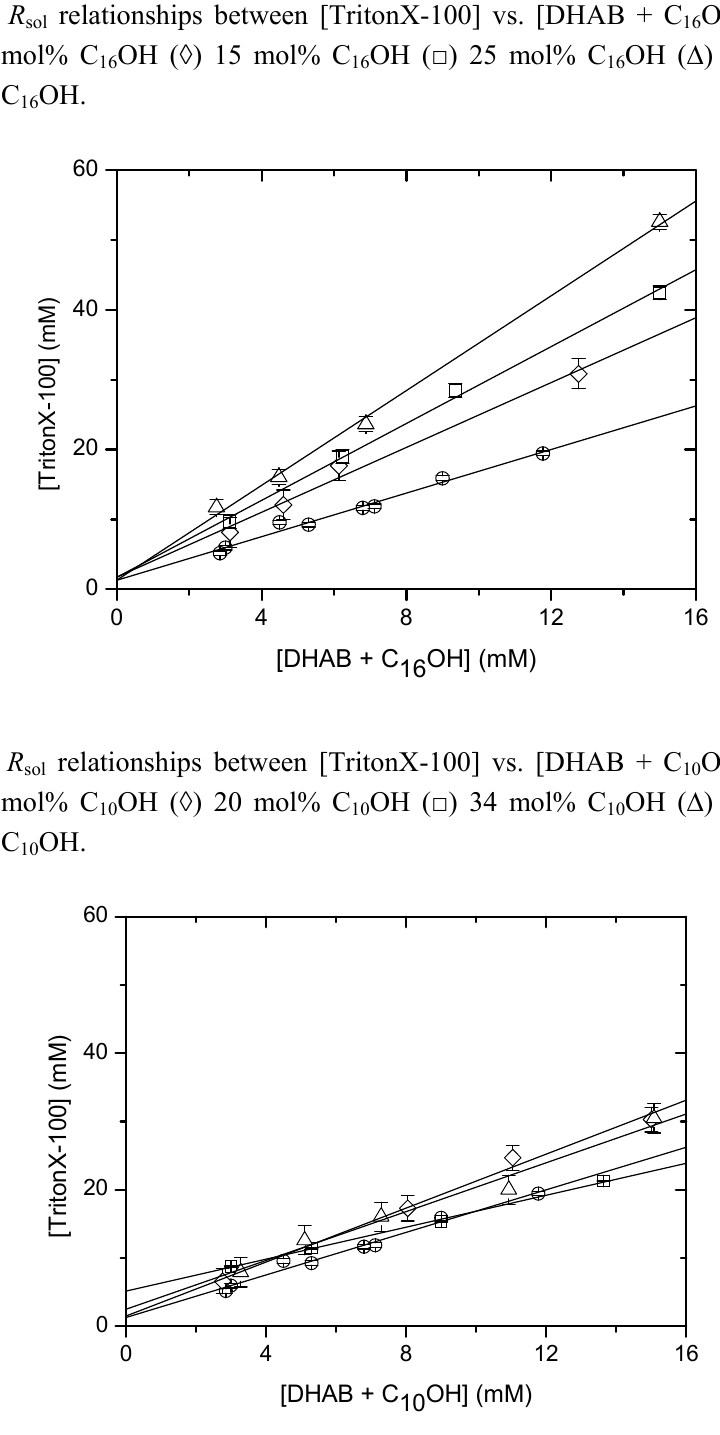
Figure 4A. R relationships between [TritonX-100] vs. [DHAB + C sol